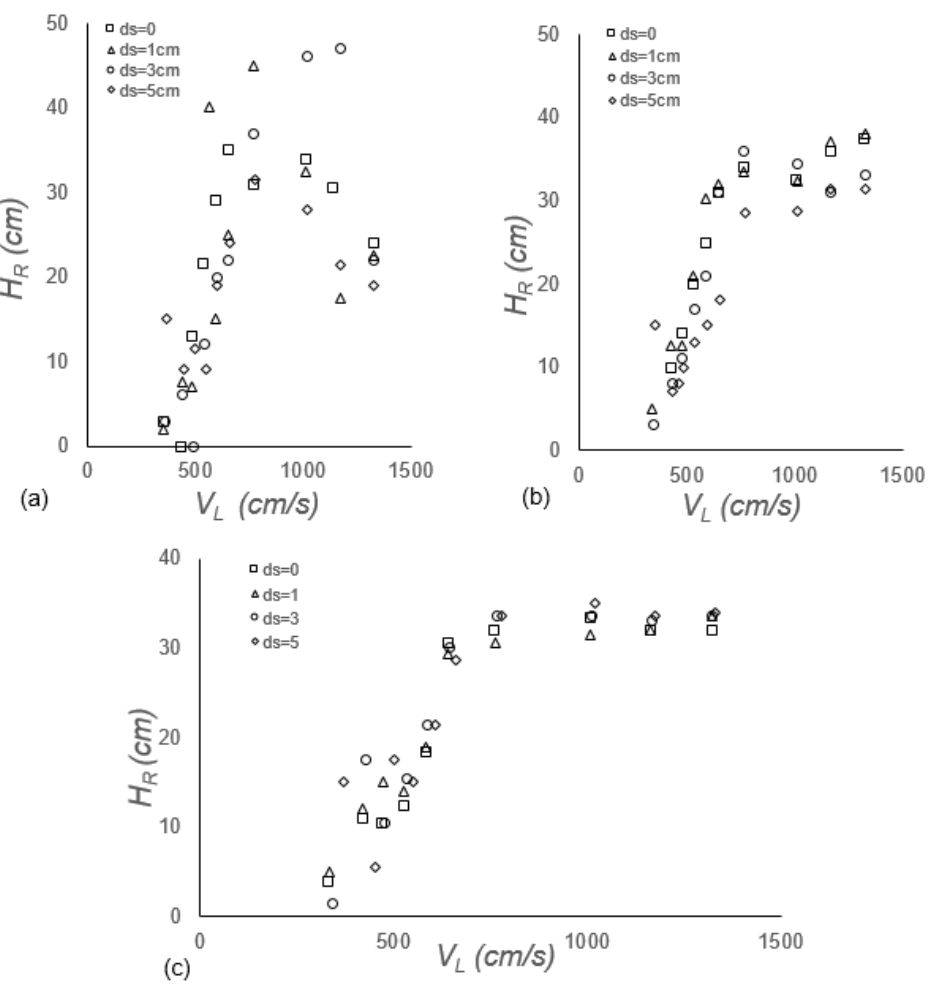
Figure 14. Rise height recorded at different d s levels for a range of jet velocities for ADR device of length ( a ) 40 cm, ( b ) 37 cm, and ( c ) 34 cm.